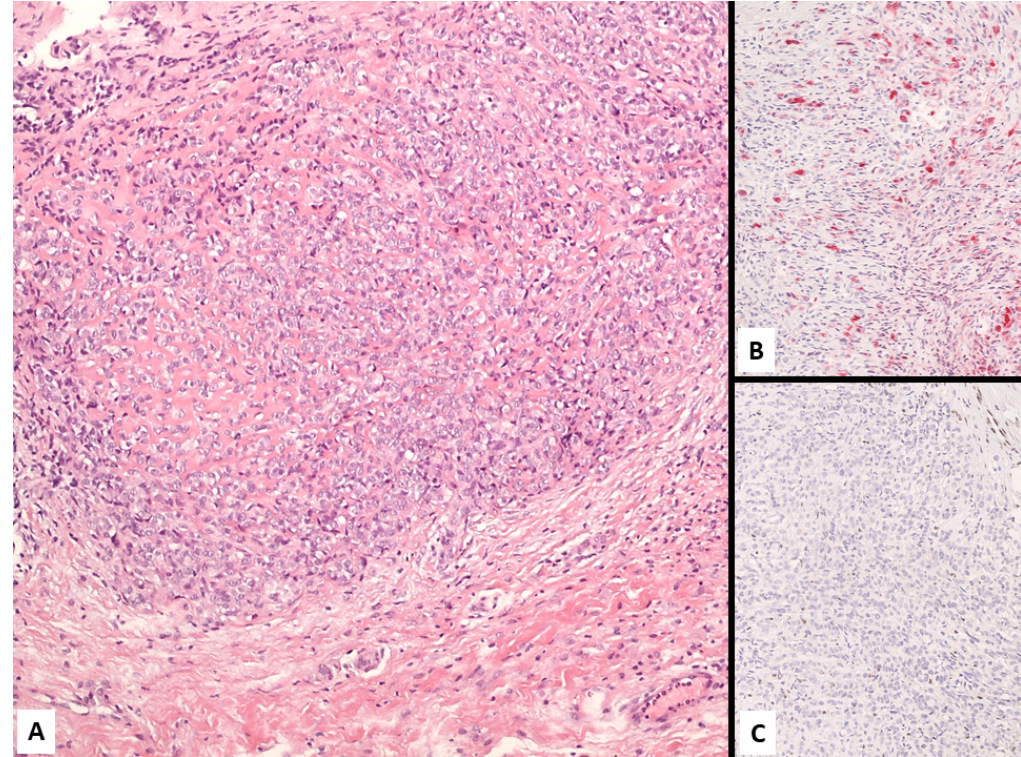
Figure 16. A poorly-differentiated malignant mesothelioma consisting of monomorphic small-sized epithelioid cells ( A ) showing heterogeneous expression of calretinin in scattered tumor cells ( B ). Negative staining with BAP1 supported the diagnosis of malignant mesothelioma ( C ).